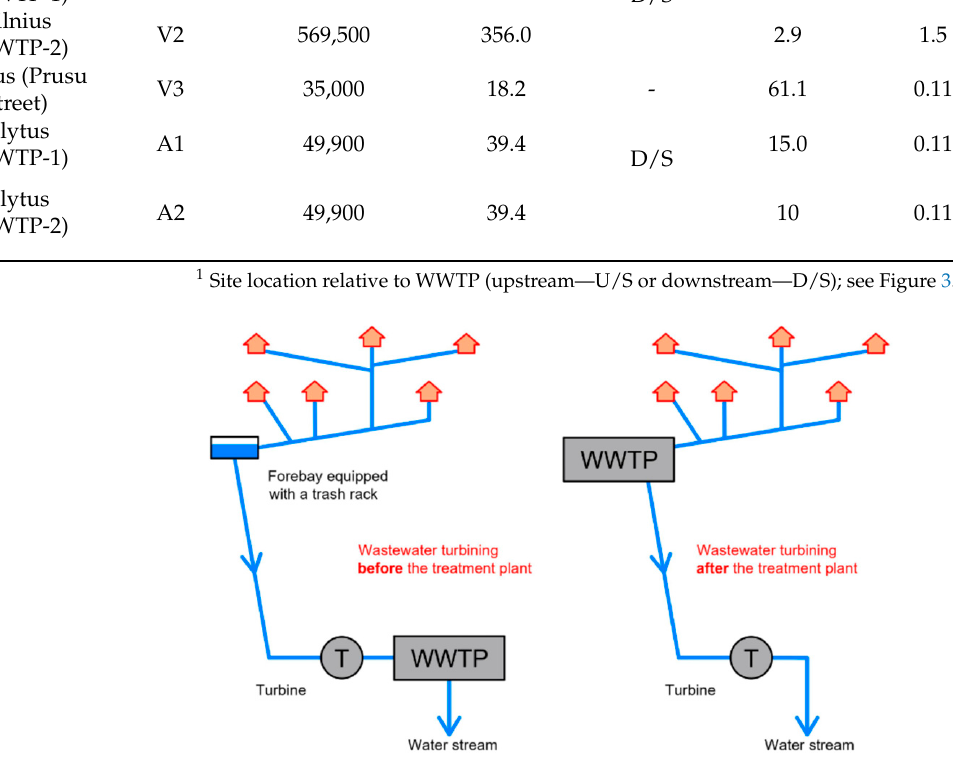
Figure 3. Turbine positions upstream and downstream of the wastewater treatment plant [6].